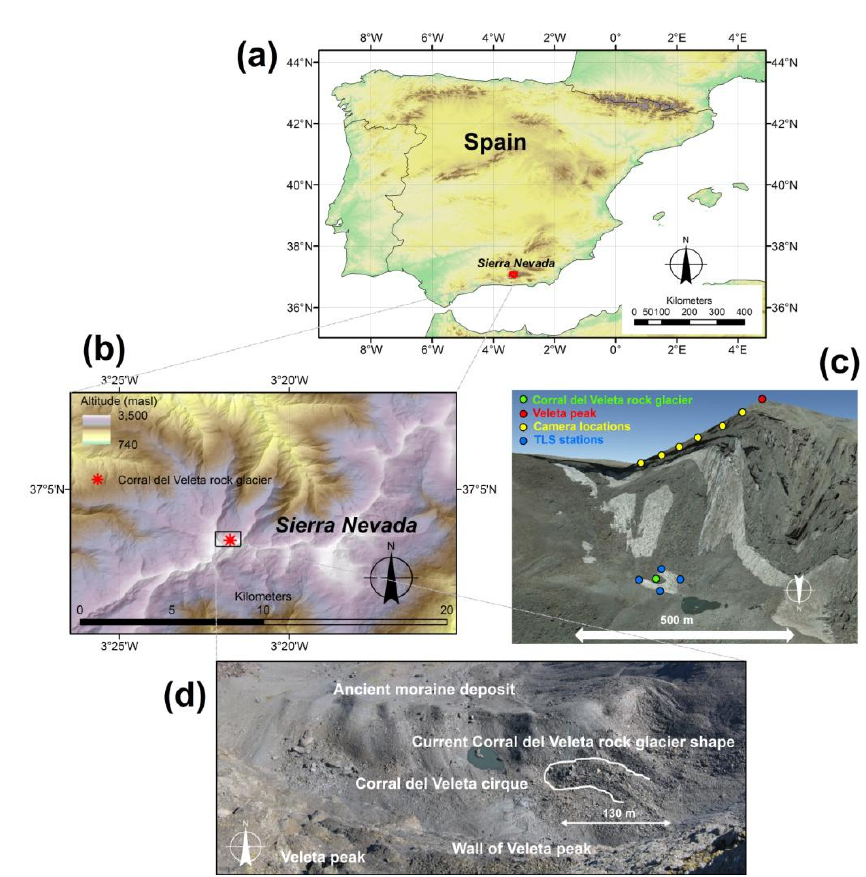
Figure 1. ( a ) location of Sierra Nevada mountain range in the Iberian Peninsula, ( b ) location of the Corral del Veleta rock glacier in Sierra Nevada, ( c ) 3D view (from the S) of the study area, including camera locations and Terrestrial Laser Scanner (TLS) stations and ( d ) Panoramic almost vertical view of the Corral del Veleta cirque from the Veleta peak (3398 masl) and the current location of the Corral del Veleta rock